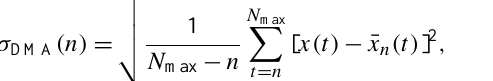
Fig. 9. A comparison between the actual local Hurst exponent (black line) and H loc ( t ) estimated using the DMA technique (green line). The average discrepancy between the true and DMA estimated local Hurst expo- nent is about 10%.